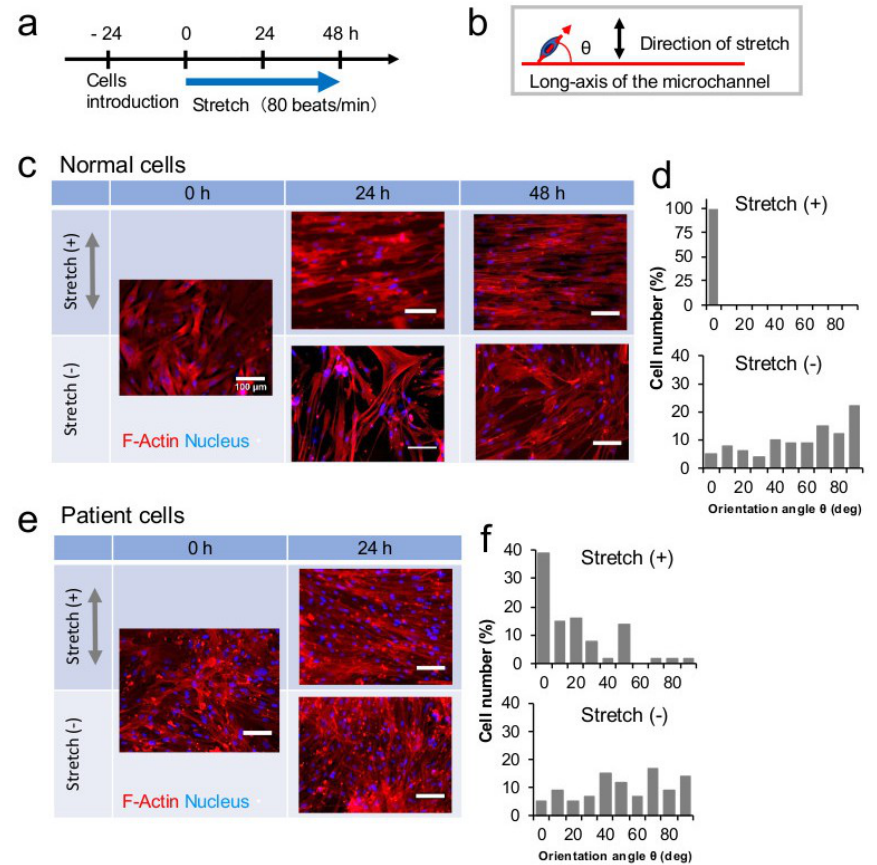
Figure 3. Effects of cyclic stretch on cell alignment. ( a ) Timeline of the cell stretch experiments. ( b ) Cell orientation was analyzed by measuring the orientation angle between the long axis of the cell nucleus and the microchannel. ( c ) Normal cells were stained for f-actin with rhodamine-phalloidin (red) and the nucleus was stained with Hoechst 33342 (blue). Cyclic stretch caused cells to align perpendicular to the stretch vector. ( d ) Distribution of the orientation angle in normal cells is shown in histograms (100 cells, 24 h). ( e ) Patient cells were stained as in (c). ( f ) Distribution of the orientation angle in patient cells is shown in histograms (100 cells, 24 h).